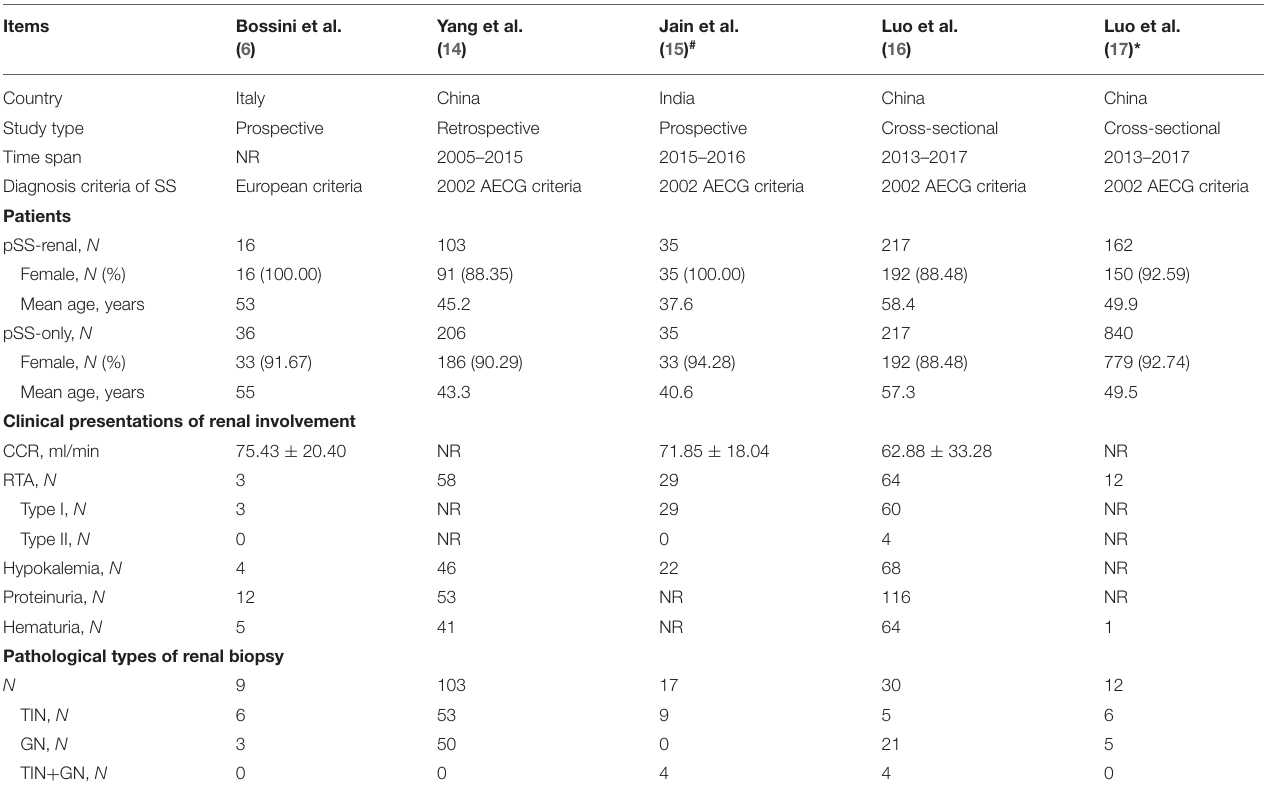
TABLE 1 | Baseline characteristics of the included studies. Items